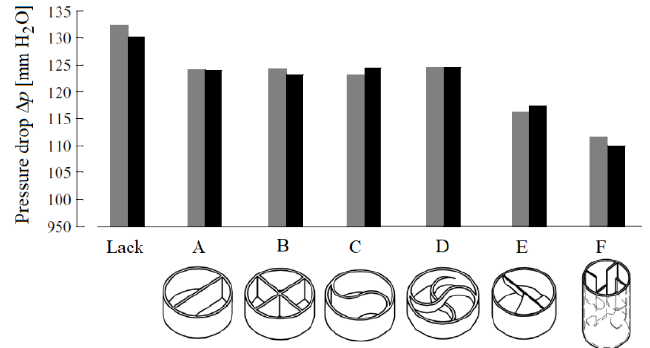
Figure 17. Pressure drop values for individual components used to straighten the flow inside the cyclone outlet tube of Samsung Gwangju Electronics Co. Figure made by author based on data from paper [83].